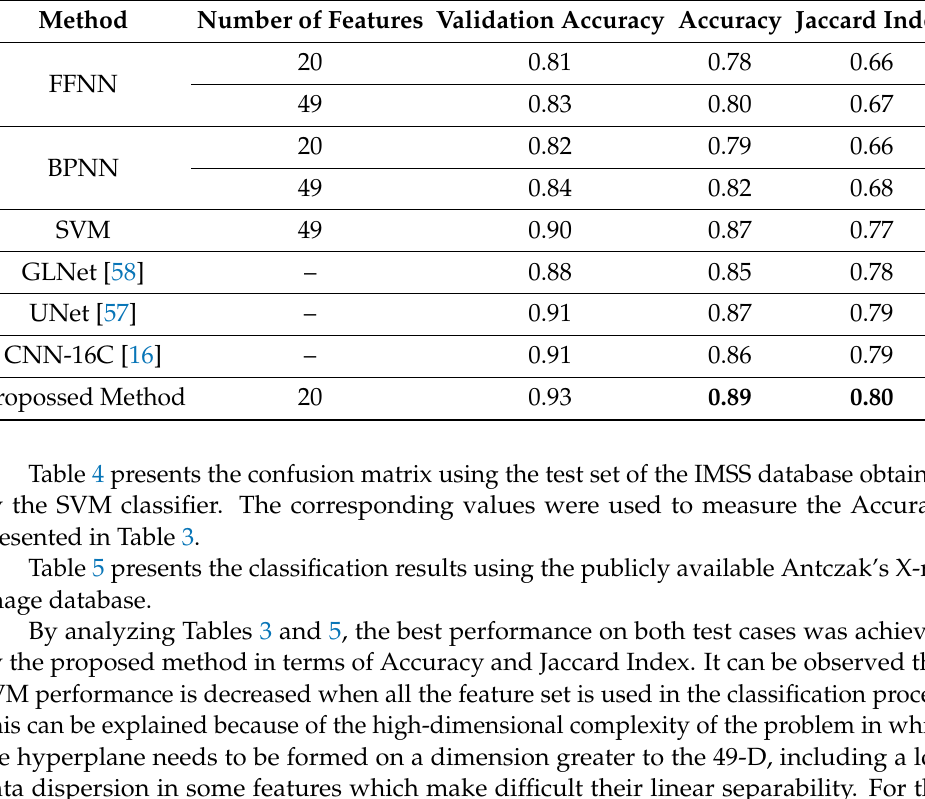
Table 3. Performance comparison of the proposed method using the database of the Mexican Social Security Institute